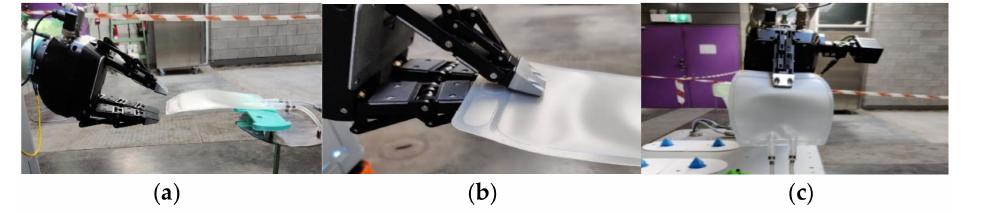
Figure 5. Handling of infusion bags ( a ) Bags kept on a stand and presented to the robot ( b ) Picking up ( c ) Moving the bag to the